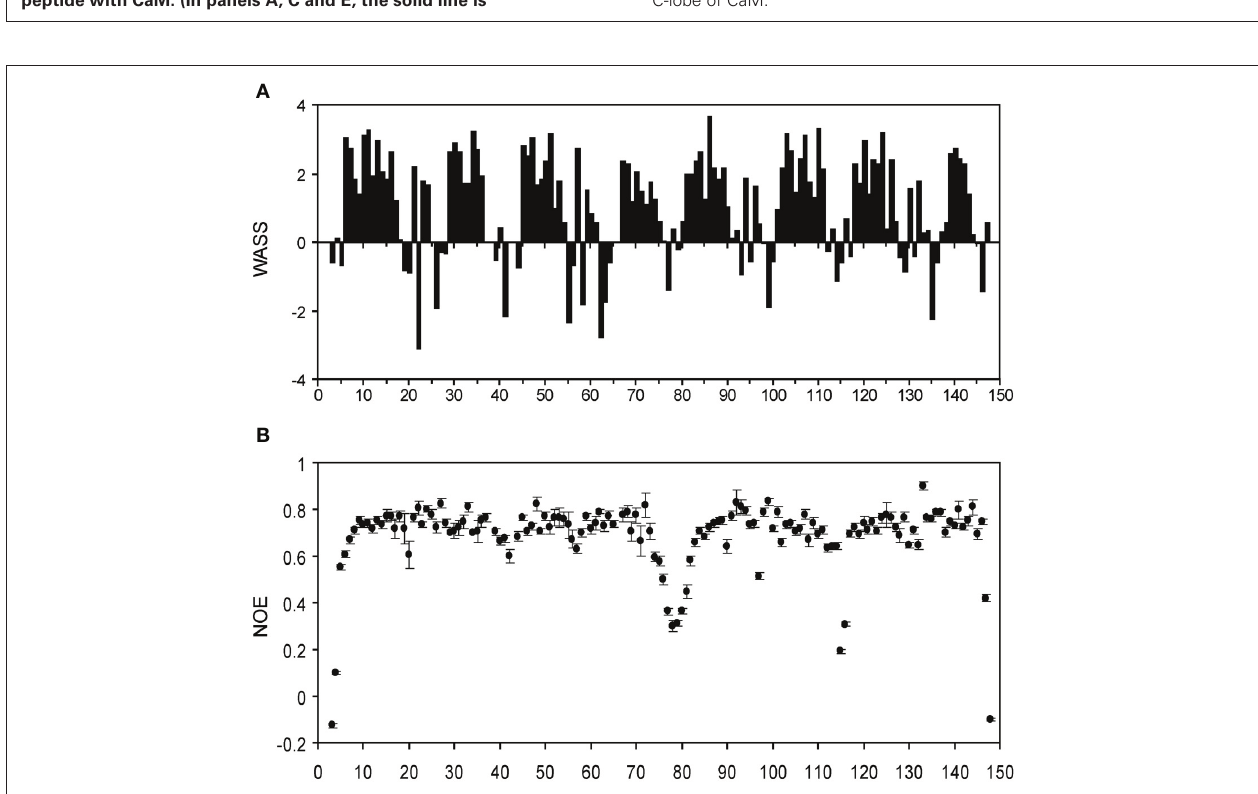
recorded without protein and the dotted line is after addition of protein). (A, B) Intact CaM, (C, D) N-lobe of CaM, (E, F) C-lobe of CaM.